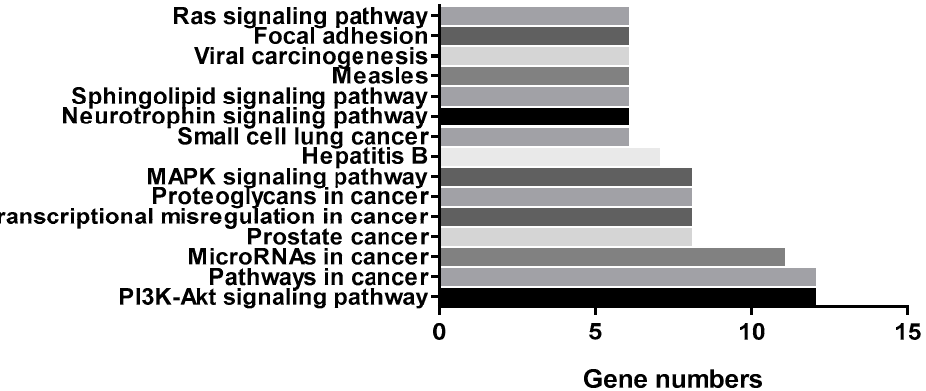
Figure 5. Number of genes in signaling pathways changed by coelonin pretreatment. 215